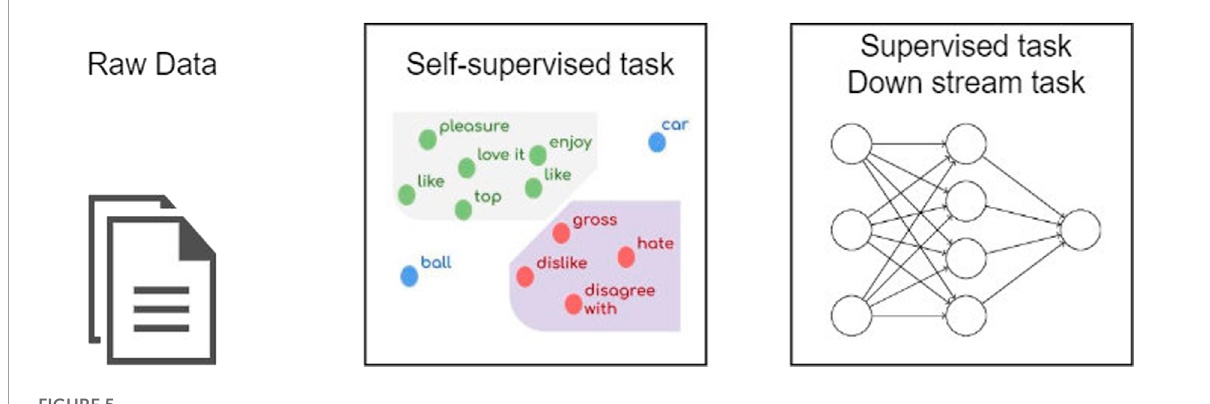
FIGURE 5 Self-supervised model in natural language